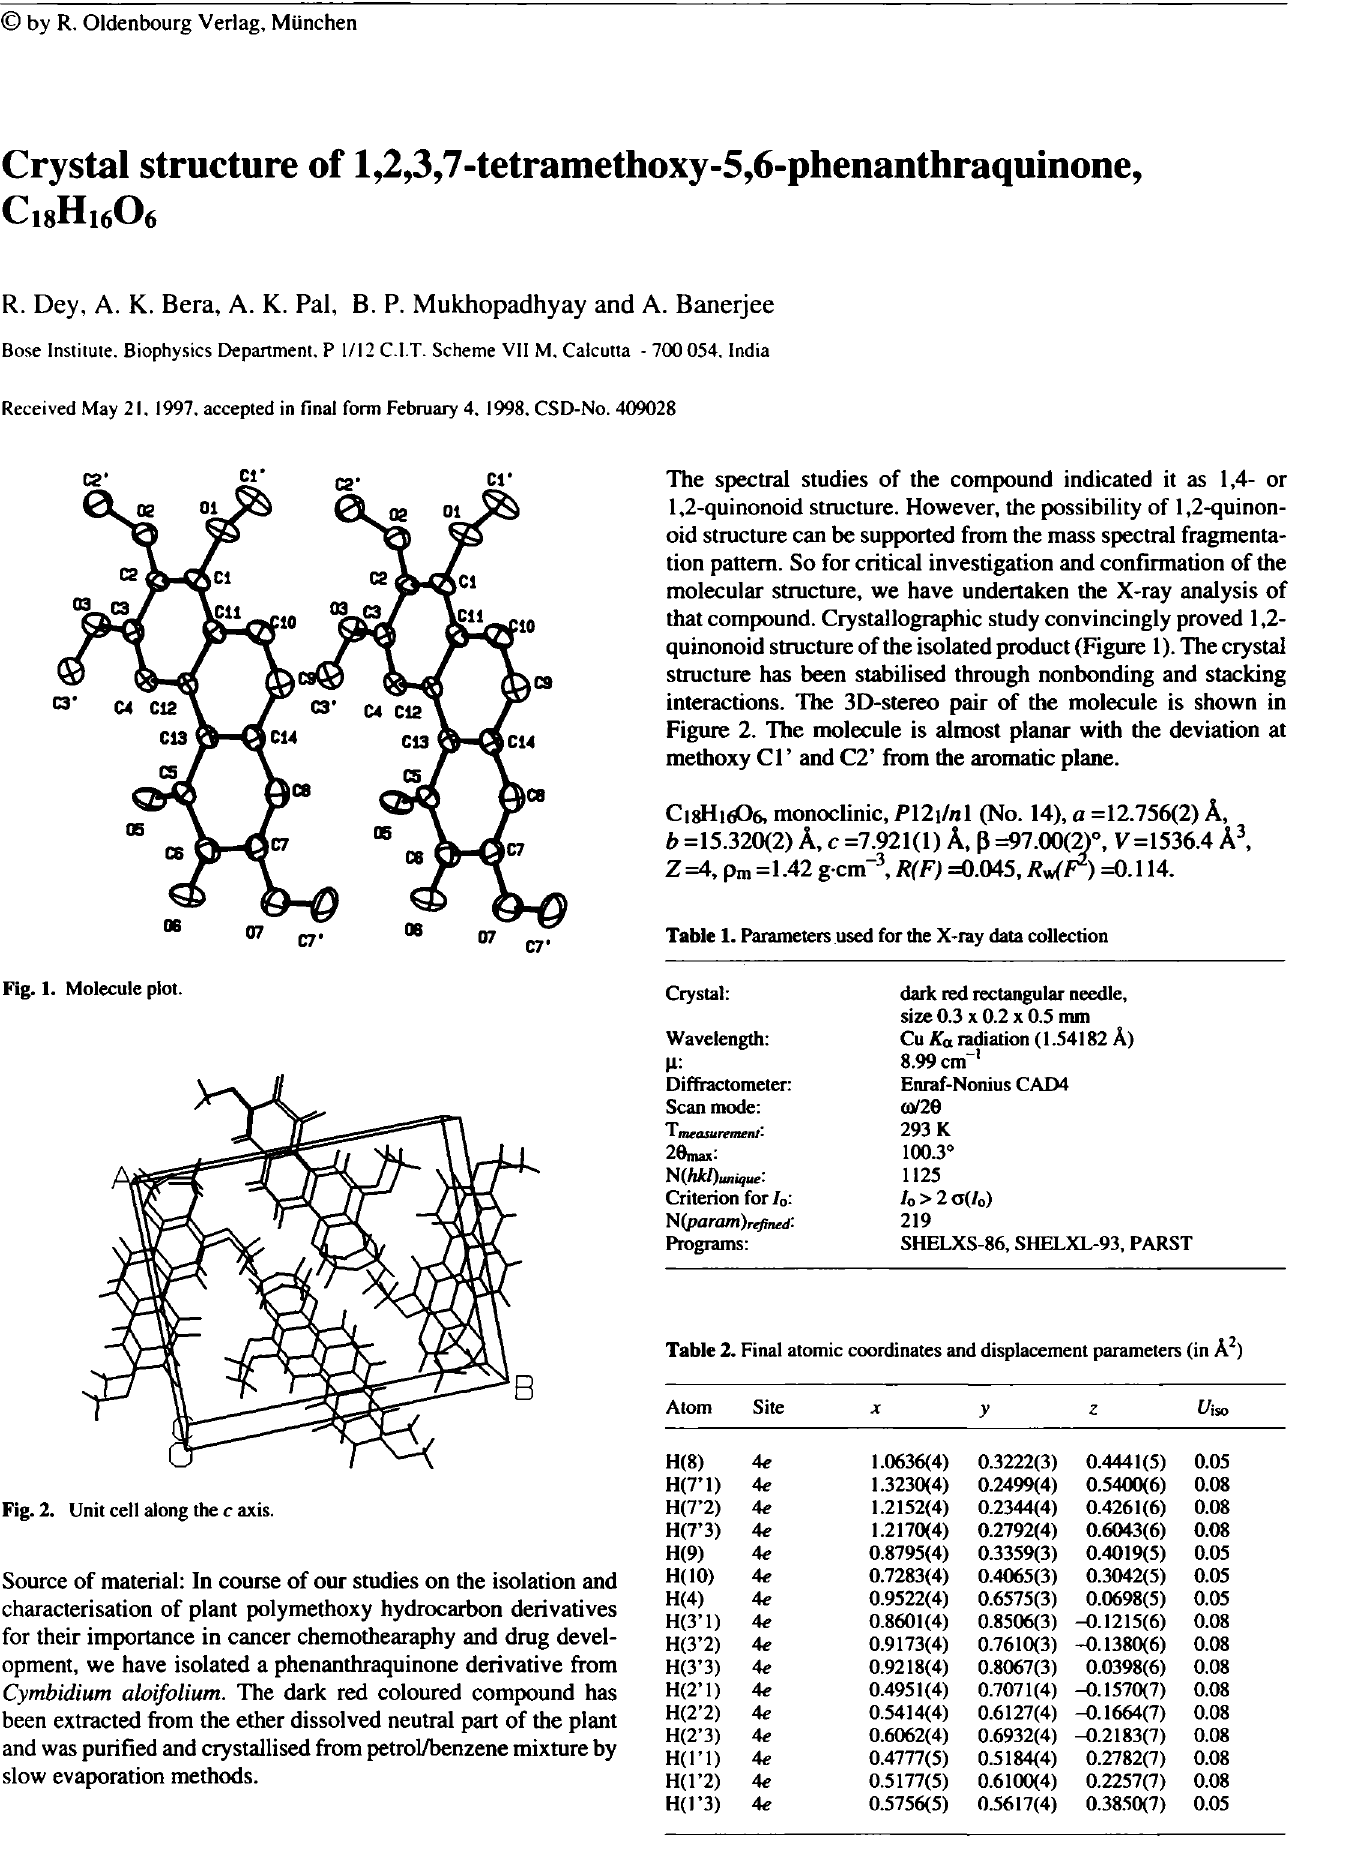
Table 2. Final atomic coordinates and displacement parameters (in